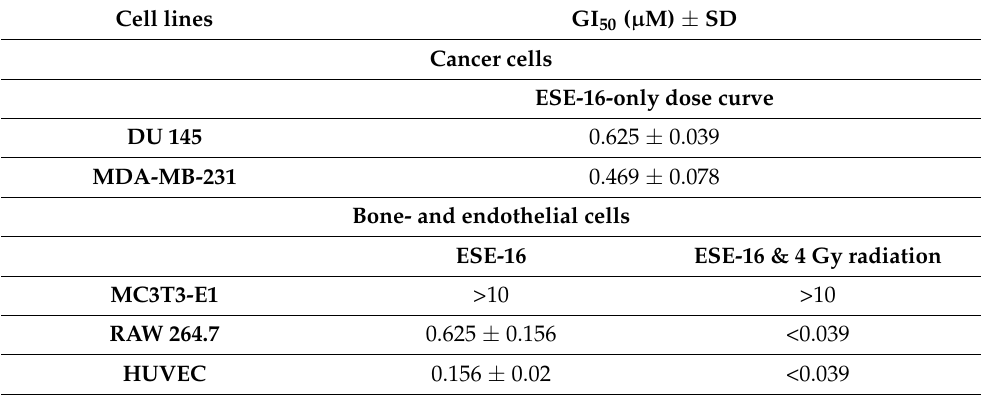
Table 1. GI 50 values ± SD in DU 145-, MDA-MB-231-, MC3T3-E1-, RAW 264.7 cells, and HUVECs exposed to ESE-16 for 48 h as well as in combination with 4 Gy